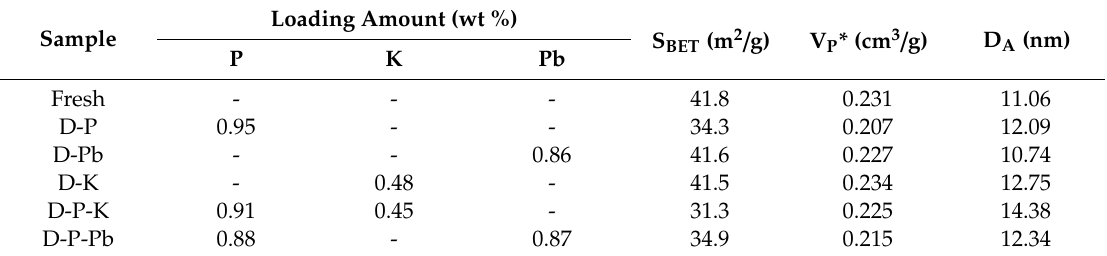
Table 1. Element loading amount, specific surface areas, total pore volume and average pore diameter of samples. Loading Amount (wt Sample